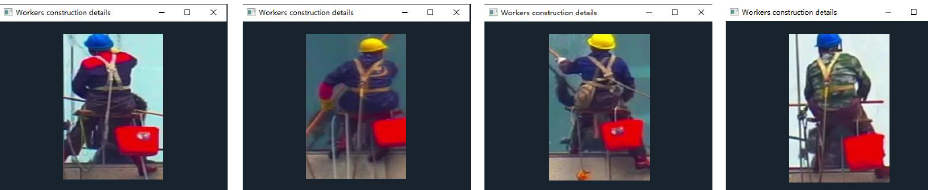
Figure 11. The visual UI interface display.